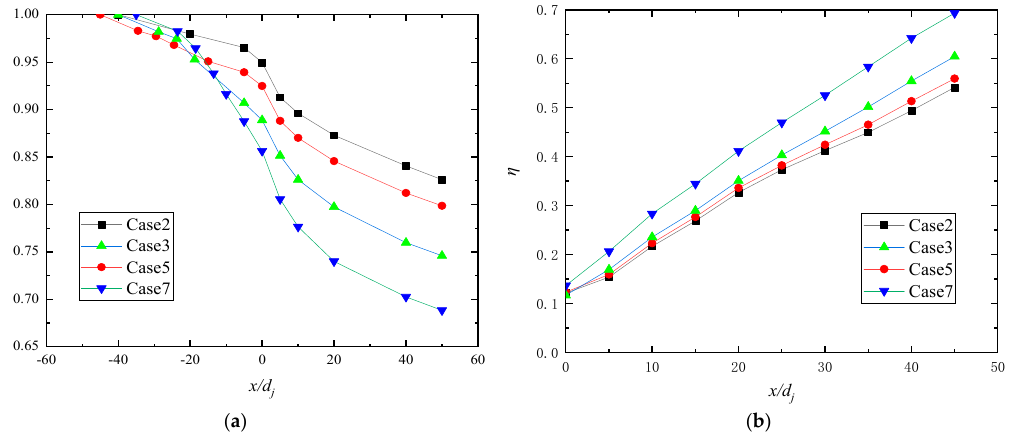
Figure 15. Comparison of mixing parameters along the flow direction of Case2, Case3, Case4, and Case7. ( a ) Total pressure recovery coefficient. ( b ) Mixing efficiency.